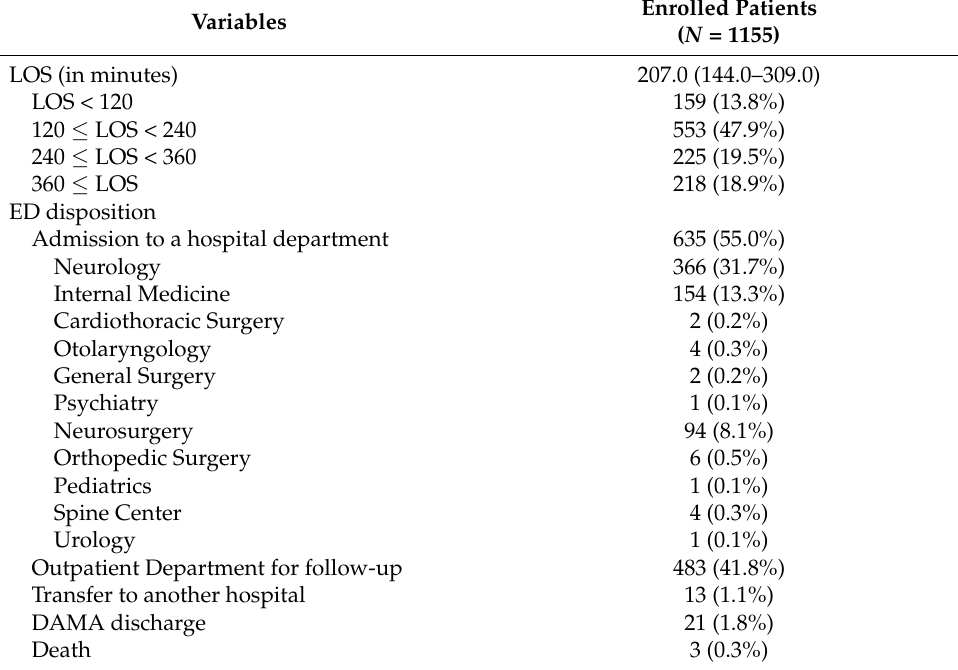
Table 4. The length of stay and disposition of the enrolled